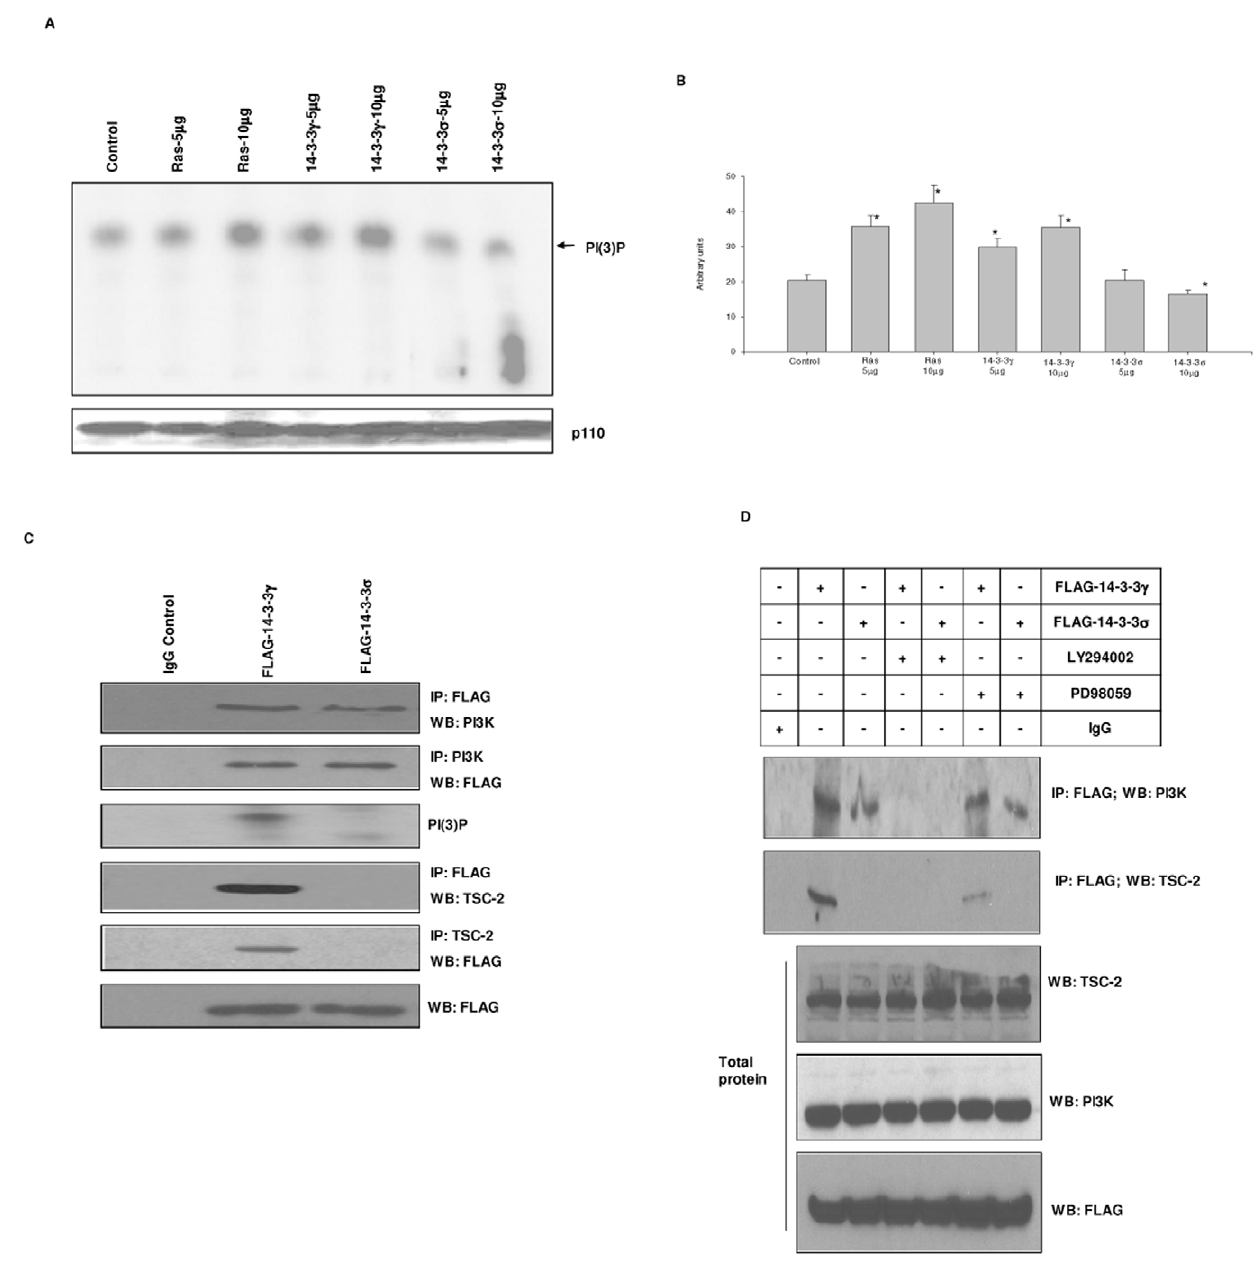
Figure 5. 14-3-3 c stimulates PI3K activity. (A) Increasingquantities of H-ras,14-3-3 c and 14-3-3 s expression plasmids were transiently transfected into NIH3T3 cells. Forty eight hours later the cells were serum starved overnight and then the cells harvested. The PI3K-p110 catalytic subunit was immunoprecipated and catalytic activity measured by incubating with phosphatidyl inositol and [ c - 32 P] ATP. Radiolabled phosphatidyl inositol was detected using thin layer chromatography (Top panel).Parallel aliquots of thesame precipitates wereresolved by SDS-PAGE and immunoblotted with anti- p110 antibody (bottom panel). The experiment was repeated three times. A typical result is depicted. (B) Radioactivity in the PI (3)-P spots from panel A was quantified. Bars in the graph are the average of the three experiments. Error bars depict standard deviation (*, p , 0.05 vs. control, Student’s t-test). (C) Extracts from NIH3T3 cells stably expressing FLAG-14-3-3 c or FLAG-14-3-3 s were prepared. 14-3-3 proteins were immunoprecipitated using an anti-FLAG antibody and probed for the presence of PI-3 kinase using an anti-p110 antibody (top panel). PI-3 kinase p110 subunit was immunoprecipitated and the precipitated proteins probed for the presence of 14-3-3 using an anti-FLAG antibody (second panel). PI3K activity was detected in the FLAG antibody immunoprecipitates by incubating with phosphatidyl inositol as described previously (third panel from the top). 14-3-3 proteins were immunoprecipitated withthe anti-FLAG antibody andtheimmunoprecipitated proteins probed for the presenceof TSC2 by immunoblotting withananti-TSC2 antibody (fourth panel from the top). TSC2 protein was immunoprecipitated from the extracts and the precipitated proteins probed for the presence of 14-3-3 proteins by immunoblotting with the anti-FLAG antibody. Total 14-3-3 protein in the extracts was detected by immunoblotting with the anti-FLAG antibody. An IgG controlis shownfor comparison. (D)14-3-3 c and 14-3-3 s stablyexpressingcells were treated witheither PD98059or LY294002as indicated. 14-3-3proteins were immunoprecipitated with an anti-FLAG antibody and the immunoprecipitated proteins probed for PI-3 kinase by immunoblotting with an anti-p110 antibody (top panel). In a parallel experiment, the FLAG antibody immunoprecipitated proteins were probed for the presence of TSC2 (second panel). Finally,the extracts were probed for total level of TSC2 (third panel), PI-3 kinase p110subunit (fourthpanel from the top), and 14-3-3 protein (bottompanel) by immunoblotting with the appropriate antibody. Proteins immunoprecipitated using an IgG control are shown for comparison.